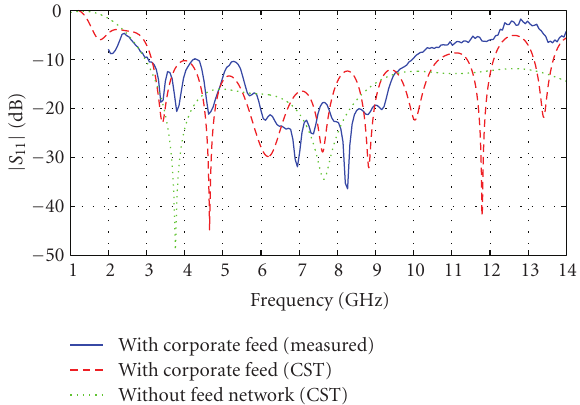
Figure 12: Simulated and measured | S 11 | curves for the two- element UWB array prototype with corporate feed ( d = 54 mm) compared to the array without feed network.